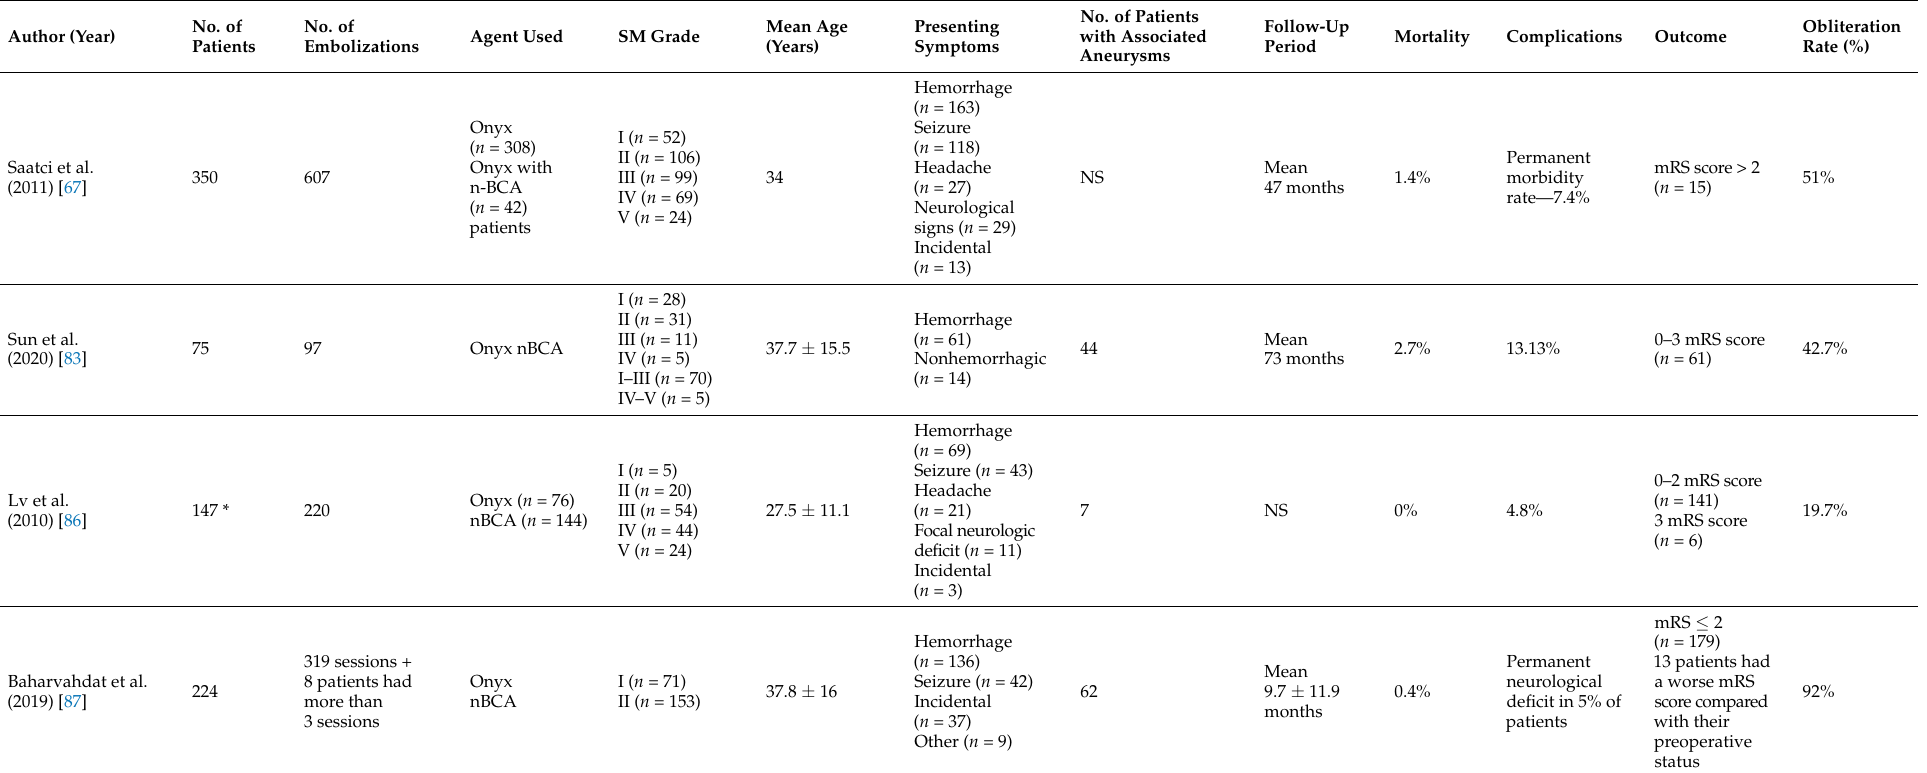
Table 2. Outcomes of selected studies using endovascular embolization in the treatment of